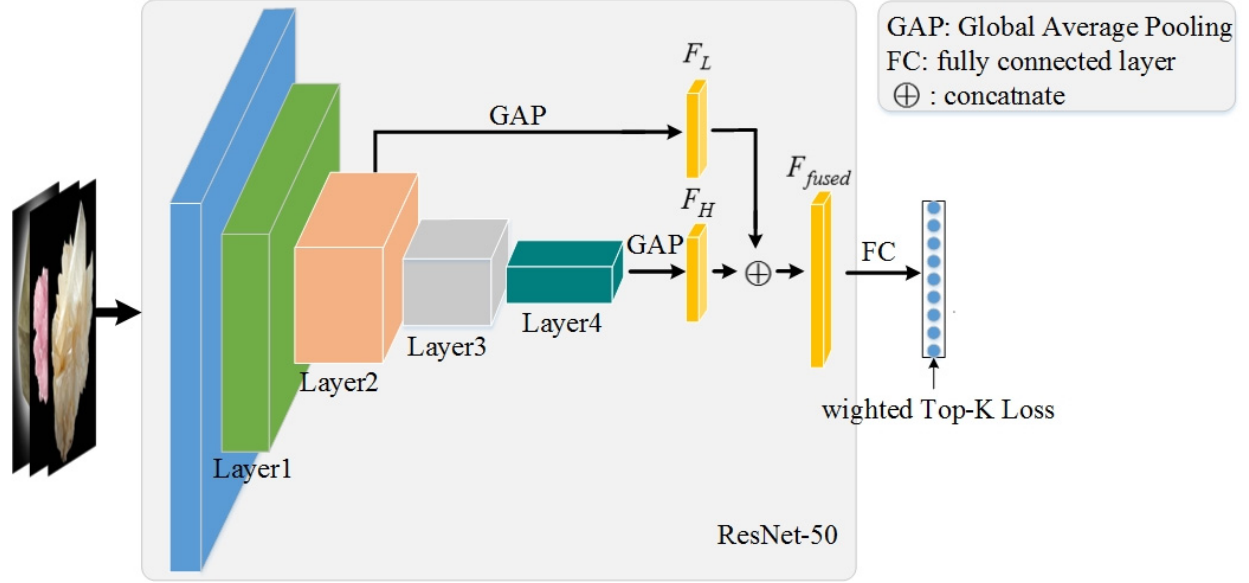
Figure 1. Mineral photos recognition based on feature fusion and weighted Top- k flow chart.